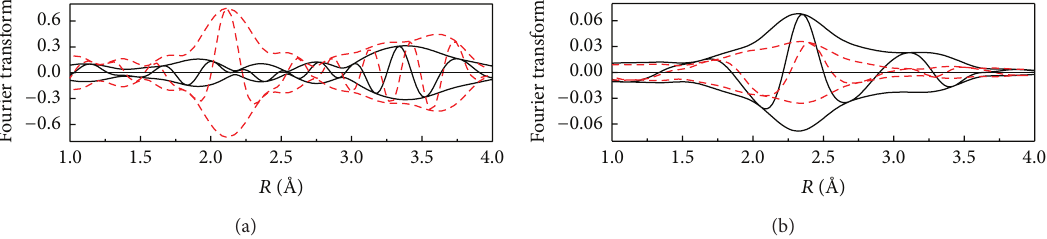
Figure 5: Illustration of the EXAFS contributions characterizing the metal-carbon interactions. (a) Imaginary part and magnitude of Fourier −1 transform( 𝑘 3 -weighted, 3.5 < 𝑘 < 13 ˚A ,Pt-Cphasecorrected)ofrawEXAFSdataatPtL III edgeminuscalculatedmetal-metalcontributions (Pt-Pt + Pt-Ru) for Pt-Ru co /C (black line) and Pt-Ru se /C (red line); (b) imaginary part and magnitude of Fourier transform ( 𝑘 1 -weighted, 3.0 < 𝑘 < 14 ˚A −1 , Ru-Cl phase corrected) of raw EXAFS data at Ru K edge minus calculated metal-metal contributions (Ru-Ru + Ru-Pt) for Pt-Ru co /C (black line) and Pt-Ru se /C (red line).